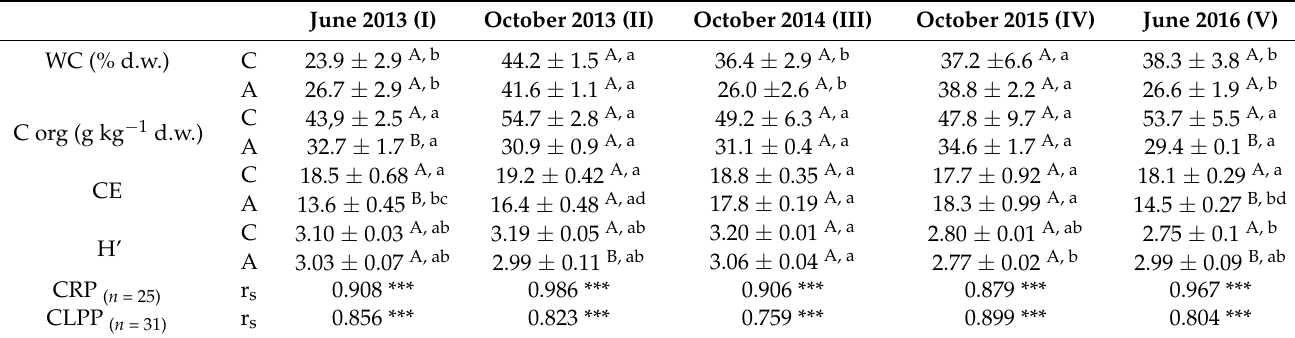
Uppercase letters indicate statistical differences between the A and C soils for each sampling, whereas lowercase letters indicate, for each soil, statistical differences among samplings. Different letters correspond to significant differences with p < 0.05. The last two rows report the Spearman correlation coefficients (r s ) between the substrate utilization profiles of the two soils obtained by the two methods (*** = p <